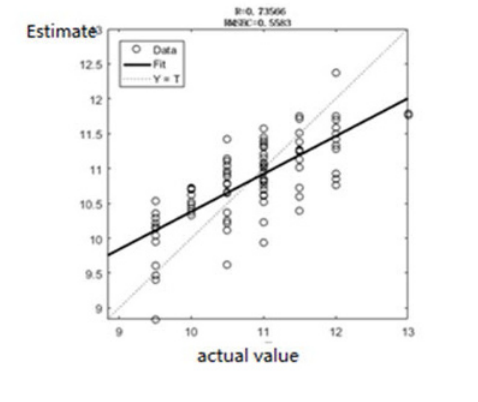
Fig. 4. SNV+ principal component analysis method is to establish the correlation image between the predicted value and the actual value of hardness